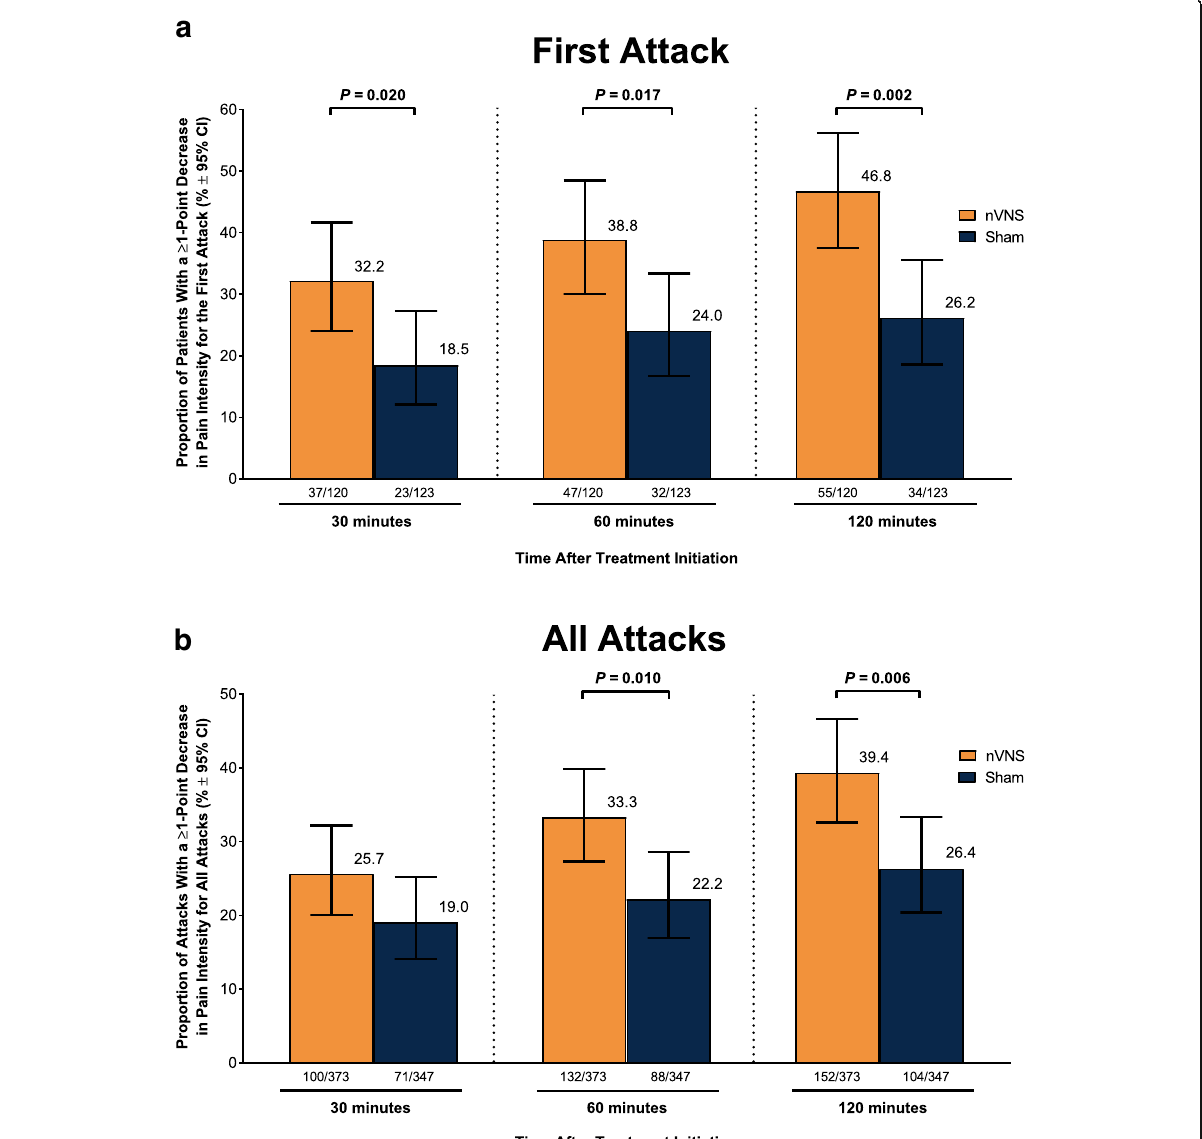
Fig. 3 ≥ 1-Point Reduction in Pain Intensity at 30, 60, and 120 Minutes for ( a ) First Attack and ( b ) All Attacks. Models are adjusted for the patients' baseline pain score, use of preventive therapies, and presence of aura; data for number of patients are unadjusted numbers. Abbreviation: nVNS, non-invasive vagus nerve